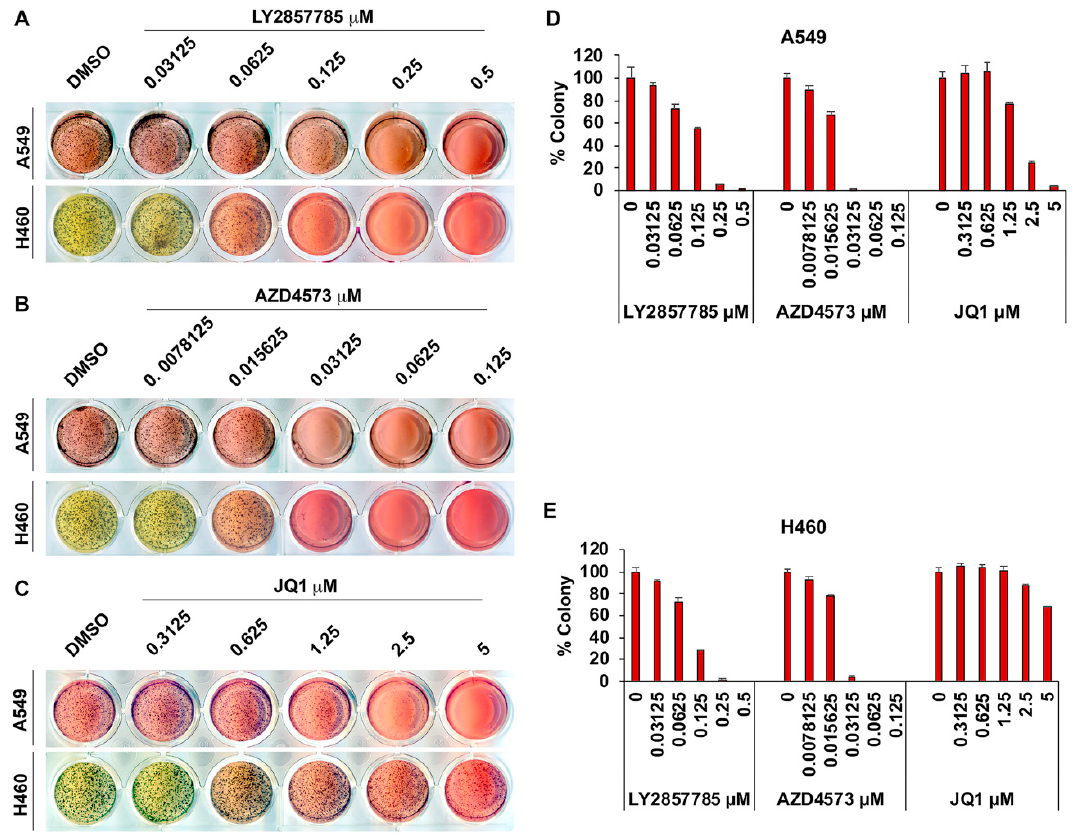
Figure 4. Anchorage-independent growth of lung cancer cells is suppressed by CDK9 inhibitors: ( A – C ): soft agar colony formation assay conducted using A549 and H460 cells in the presence of varying concentrations of the CDK9 inhibitors LY2857785 (~31 to 500 nM) and AZD4573 (~8 to 125 nM) or the BRD4 inhibitor JQ1 (~0.3 to 5 µM) show that CDK9 inhibitors effectively inhibit the anchorage-independent growth at low nanomolar concentrations. JQ1 also reduced colony formation at 2.5 µM in A549 cells but not in H460 cells. ( D , E ) Bar graphs show quantification of the colonies from A549 ( D ) and H460 ( E ) cells treated with the inhibitors.